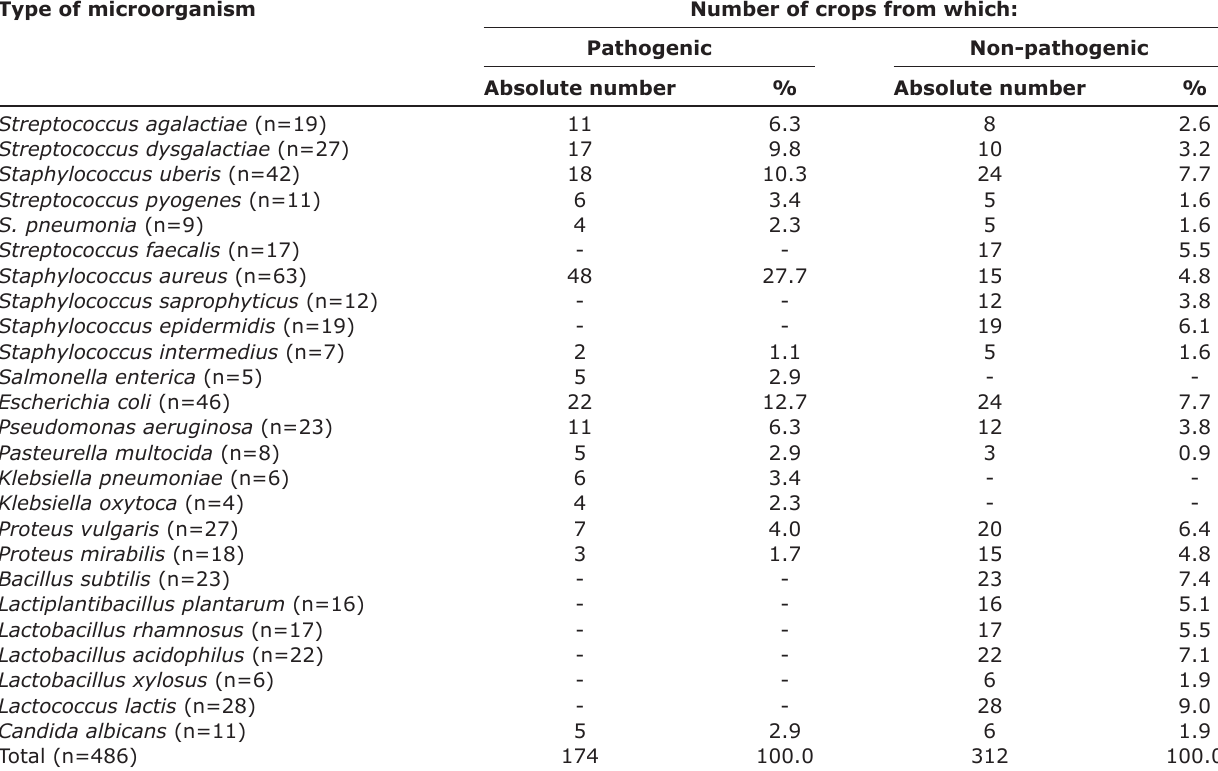
Table-5: Pathogenicity for white mice that isolated cultures of microorganisms in